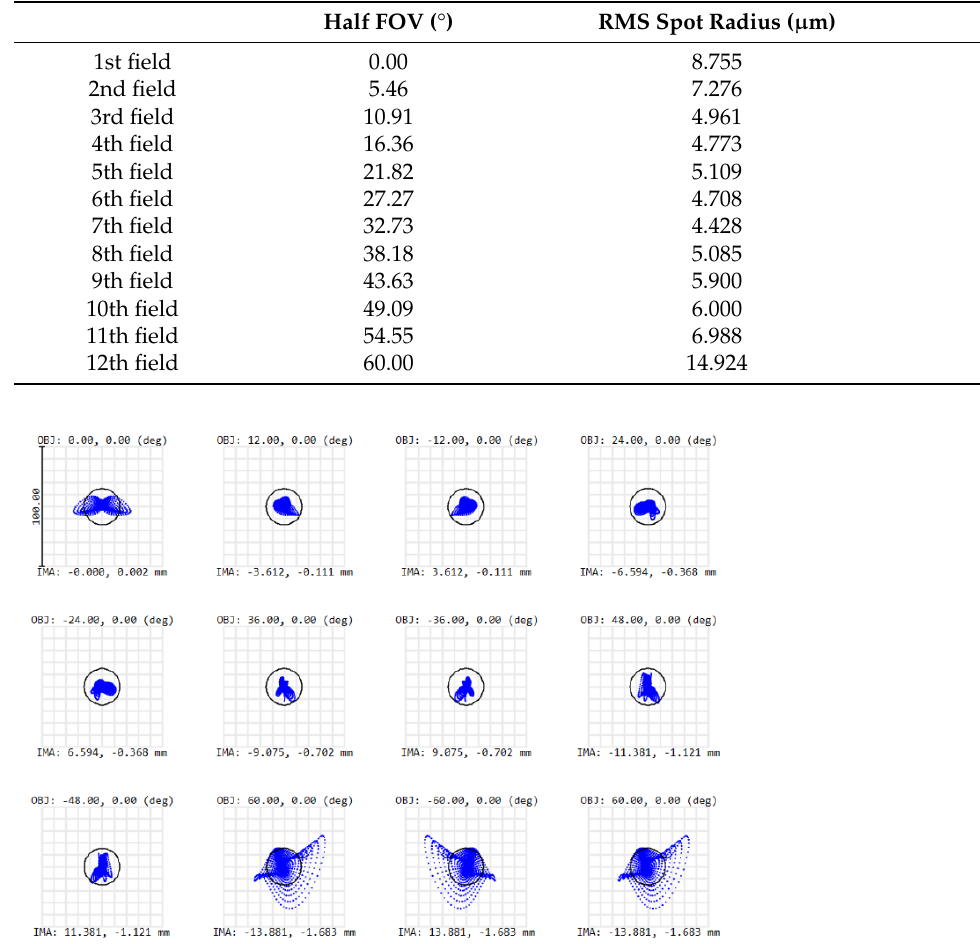
Table 1. RMS spot radii at 1700 nm over the full field of view. For each field, the root-mean-square size of the spot is smaller than the Airy disk (radius = 14.98 µm), implying a diffraction-limited design. The results are shown for an equiangular sampling over the half field of view. Results are symmetrical with the other half of the field of view.